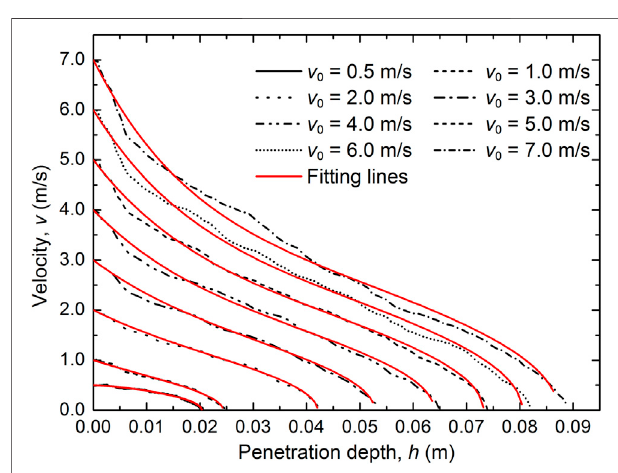
FIGURE6| Relationshipbetweenthe fi nalpenetrationdepth( h f )and the total fallingheight ( H (cid:1) h f + v 2 0 /2 g ).Theblack linecorresponds totheempirical equation obtained by Uehara et al. (3) in their experimental studies.